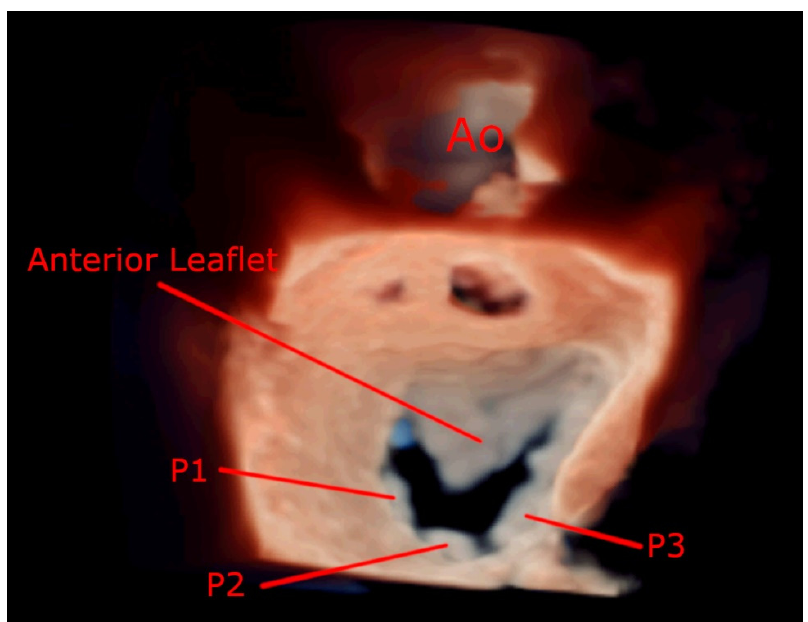
Figure 1. Zoom 3D image focused on the mitral valve from the mid-esophageal, four chamber view depicting mitral valve anatomy.